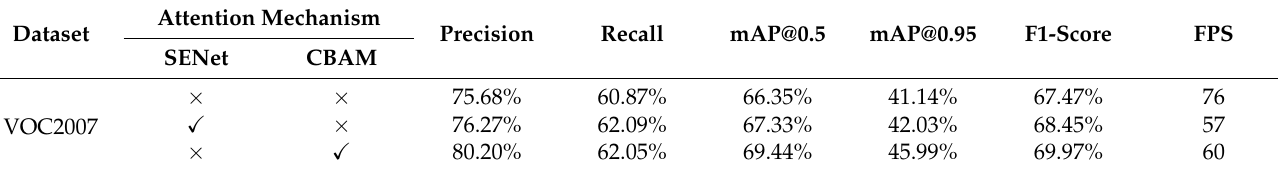
Table 3. Ablation